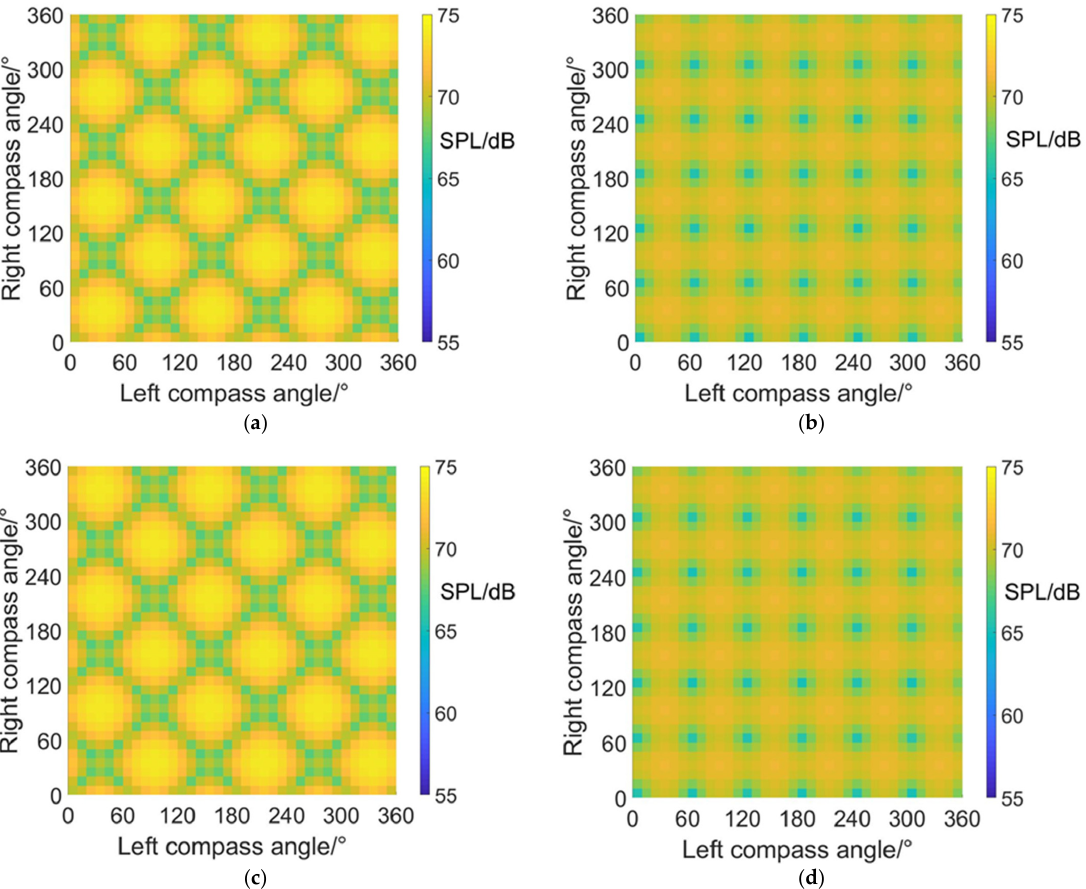
Figure 13. Carpet diagrams of noise SPL in fixed-wing mode at an azimuth angle = 0° with scissors angle difference = ( a ) 0°, ( b ) 30°, ( c ) 60°, ( d ) 90°.